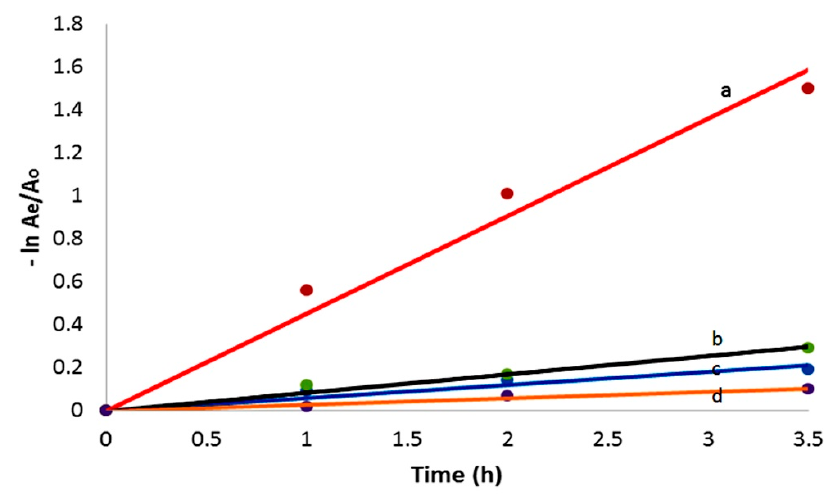
Figure 15. Kinetic study of photocatalytic degradation of acid green 1 in presence of: ( a ) Zn-Al-GO1, ( b ) Zn-Al-GO2, ( c ) Zn-Al LDH and ( d ) Zn-Al-GO3.